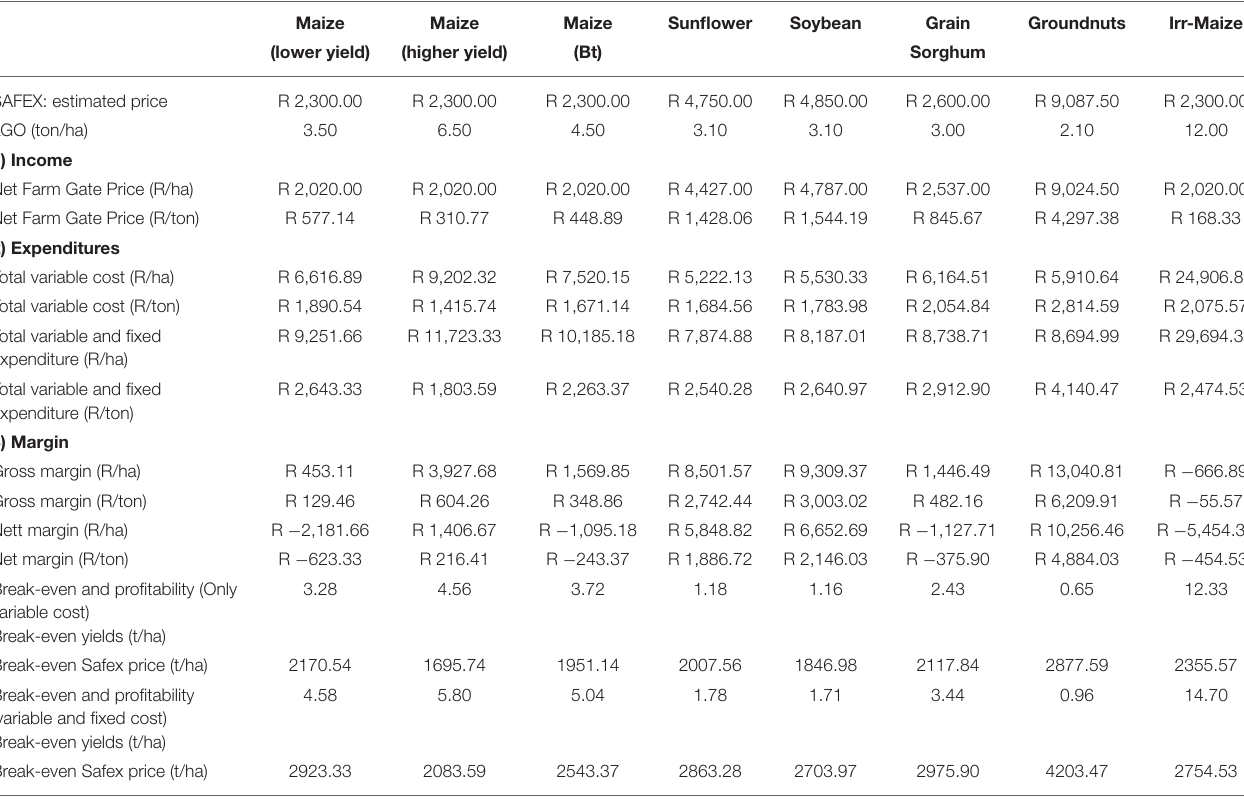
TABLE 4 | Cost-benefit analysis for selected summer crop production in the Free State Province from the period 2014 to 2018. Maize